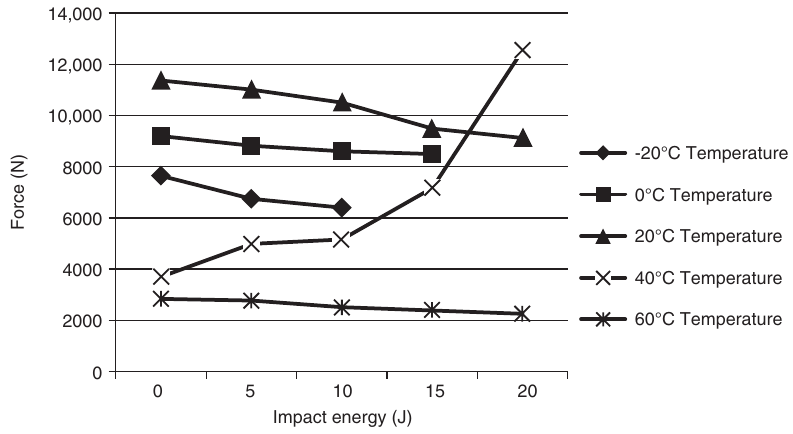
Figure 10: Failure load variations with respect to impact load energy and application